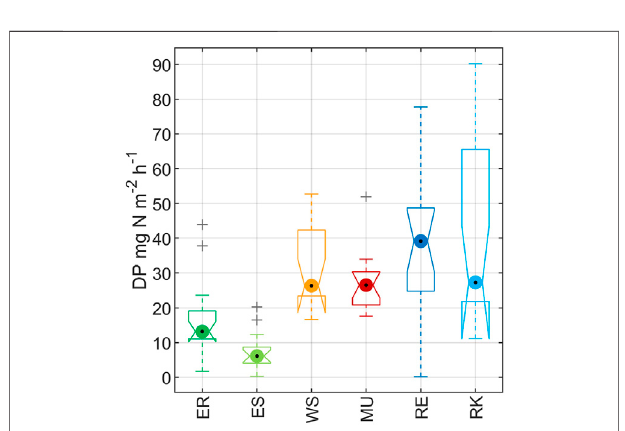
FIGURE 4 | Comparison of average soil DP between the study areas. Box lines show upper and lower quartiles. Whiskers extend to the 95th and fi fth